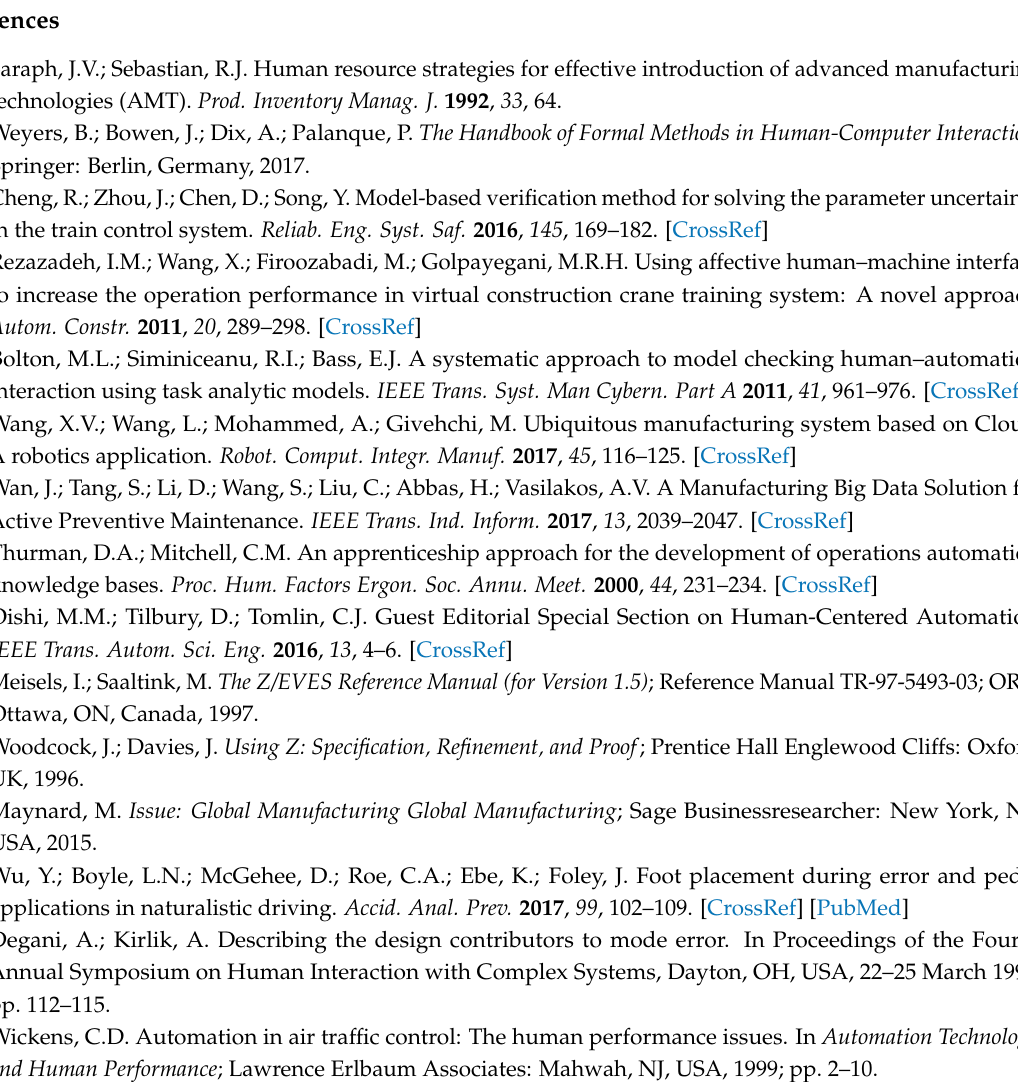
Figure A3. The snapshot of the formal specification analysis of weak bi-simulation